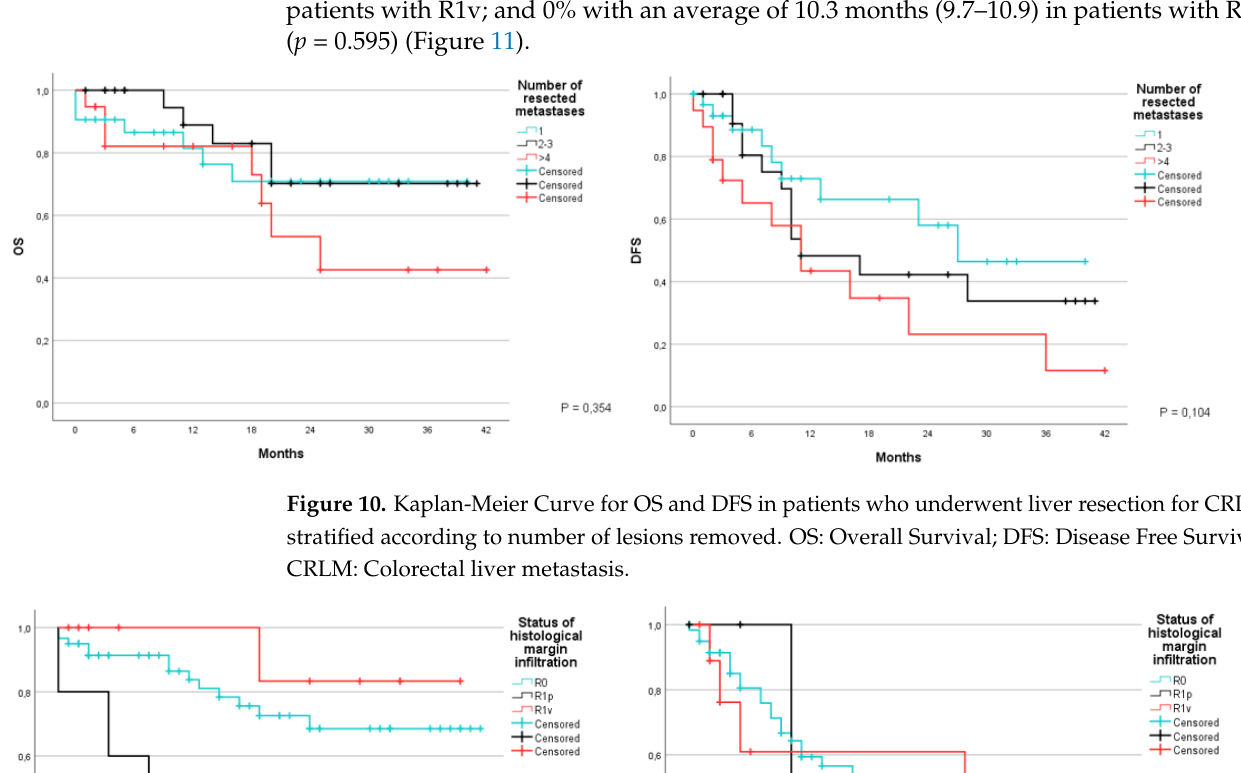
13 of 21 Figure 9. Kaplan-Meier Curve for OS and DFS in patients who underwent liver resection for CRLM stratified according to lobar involvement. OS: Overall Survival; DFS: Disease Free Survival; CRLM: Colorectal liver metastasis. Another parameter that we analyzed was the number of resected metastases during